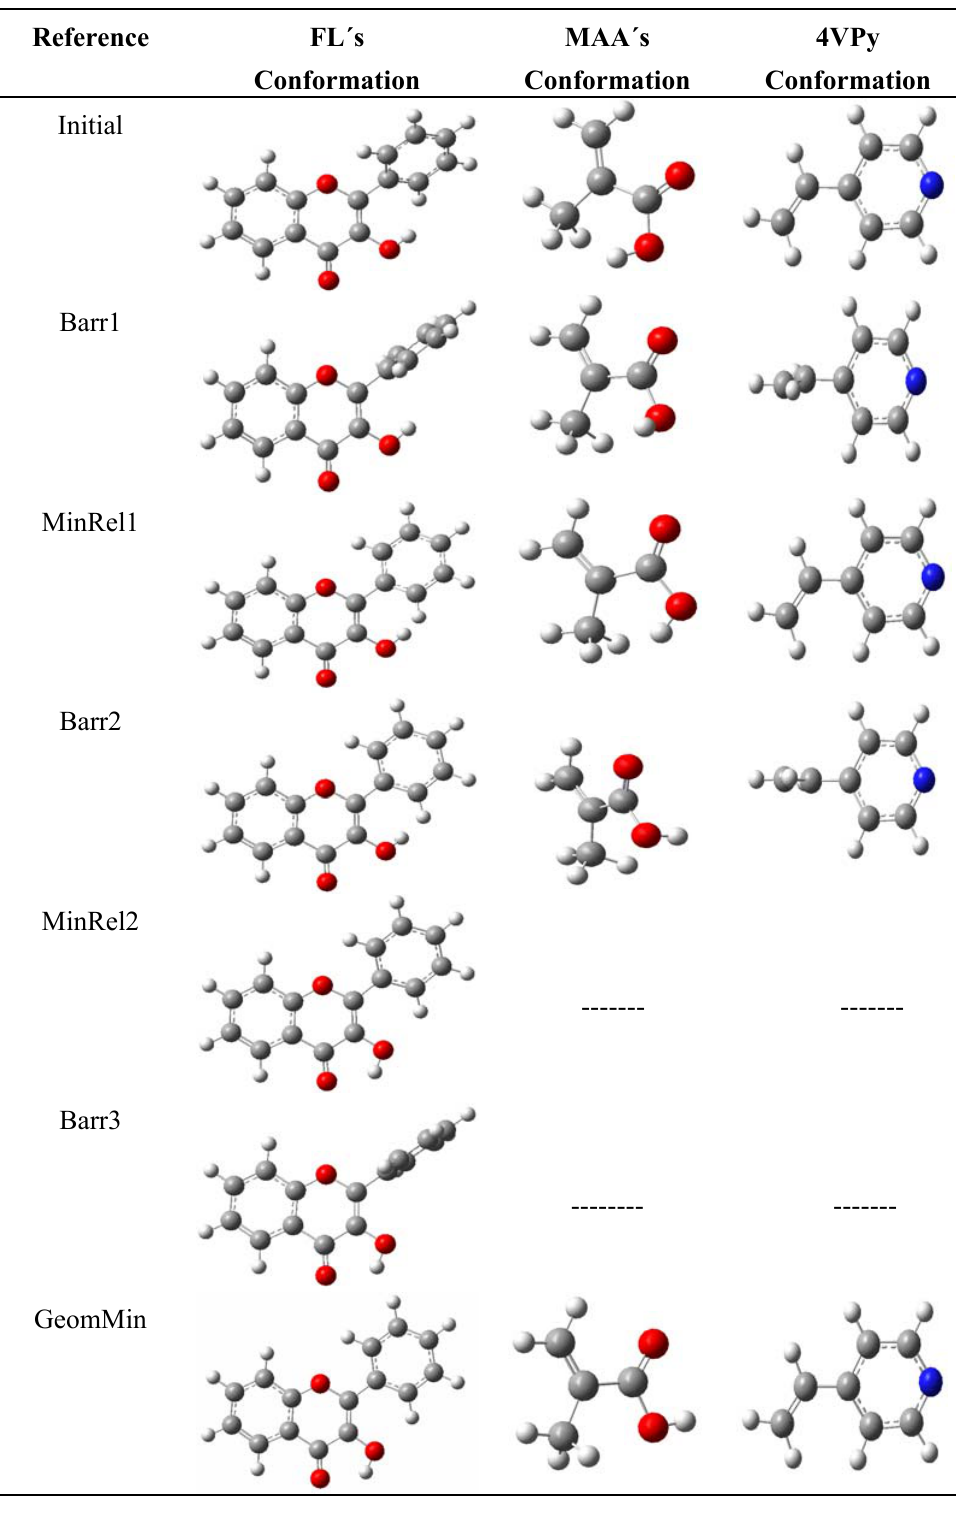
Table 1. The corresponding geometries of the graphical representation in the Figures 2, 3 and φ ) of FL, MAA and 4VPy. Barr = Barrier, and 4, for the torsion angles ( φ 2 1 MinRel = relative minima and GeomMin = geometries of minima energy, Barr1, Barr2 and Barr3 are maximums in the